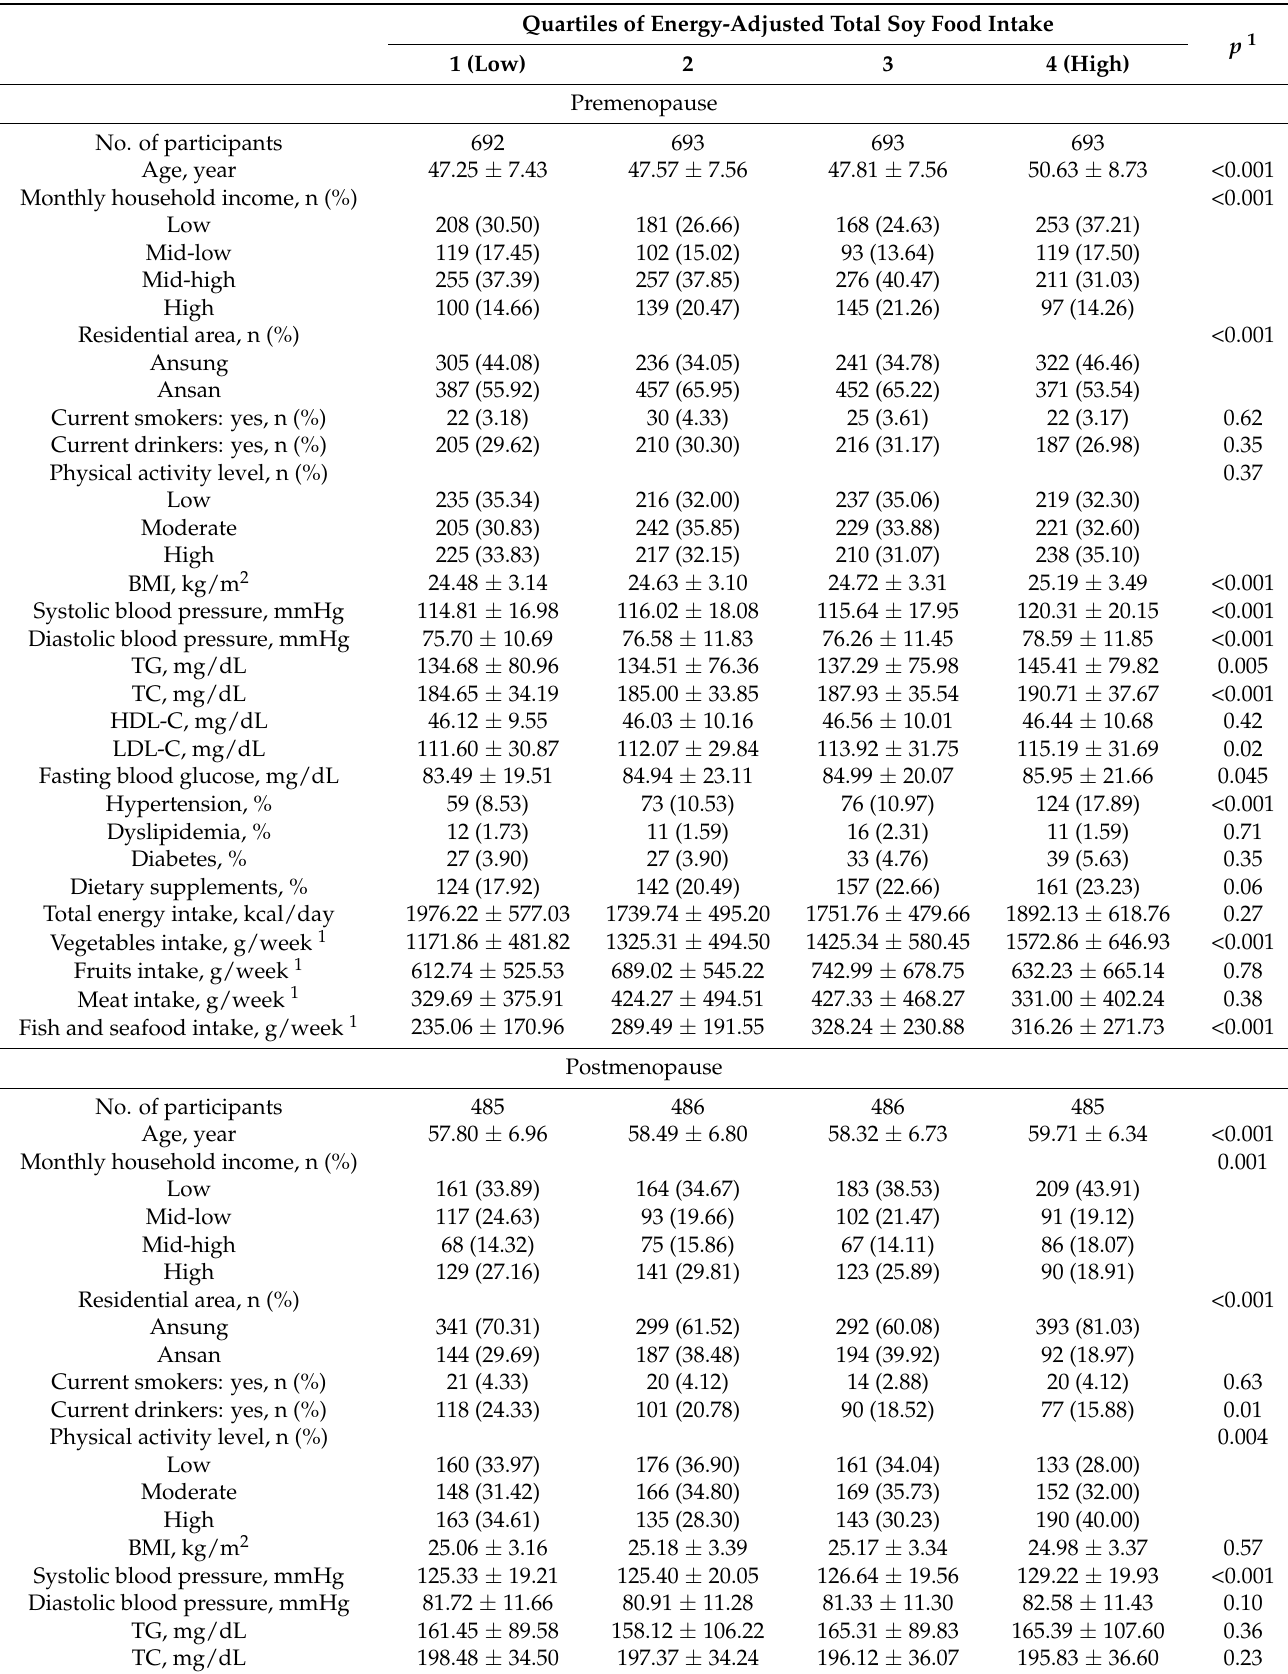
Table 1. Baseline characteristics of the study population according to the quartiles of energy-adjusted total soy food intake. Quartiles of Energy-Adjusted Total Soy Food